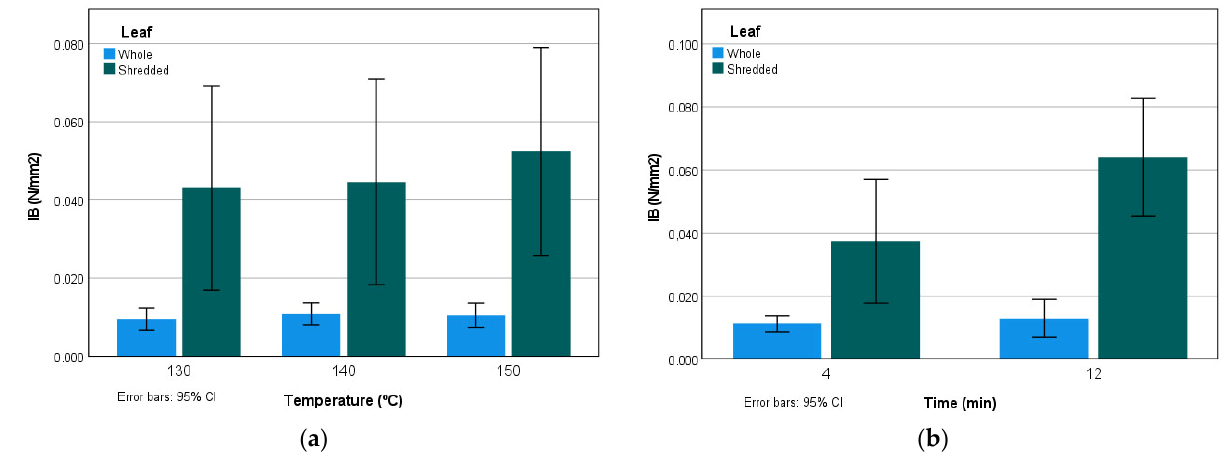
Figure 9. Internal bonding strength (IB) according to ( a ) temperature and ( b ) pressing time.